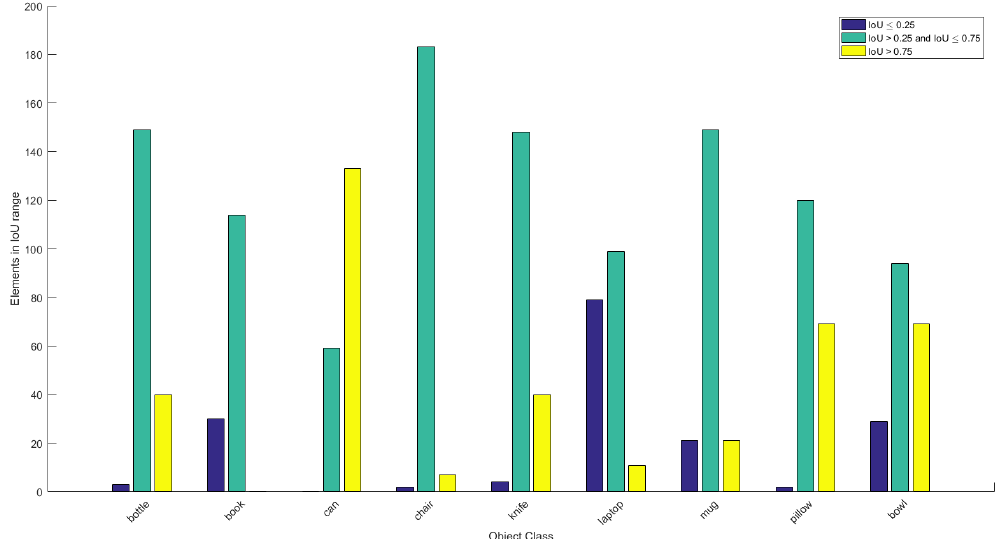
Figure 8. Histogram of the IoU values for heuristic comparison of reconstruction